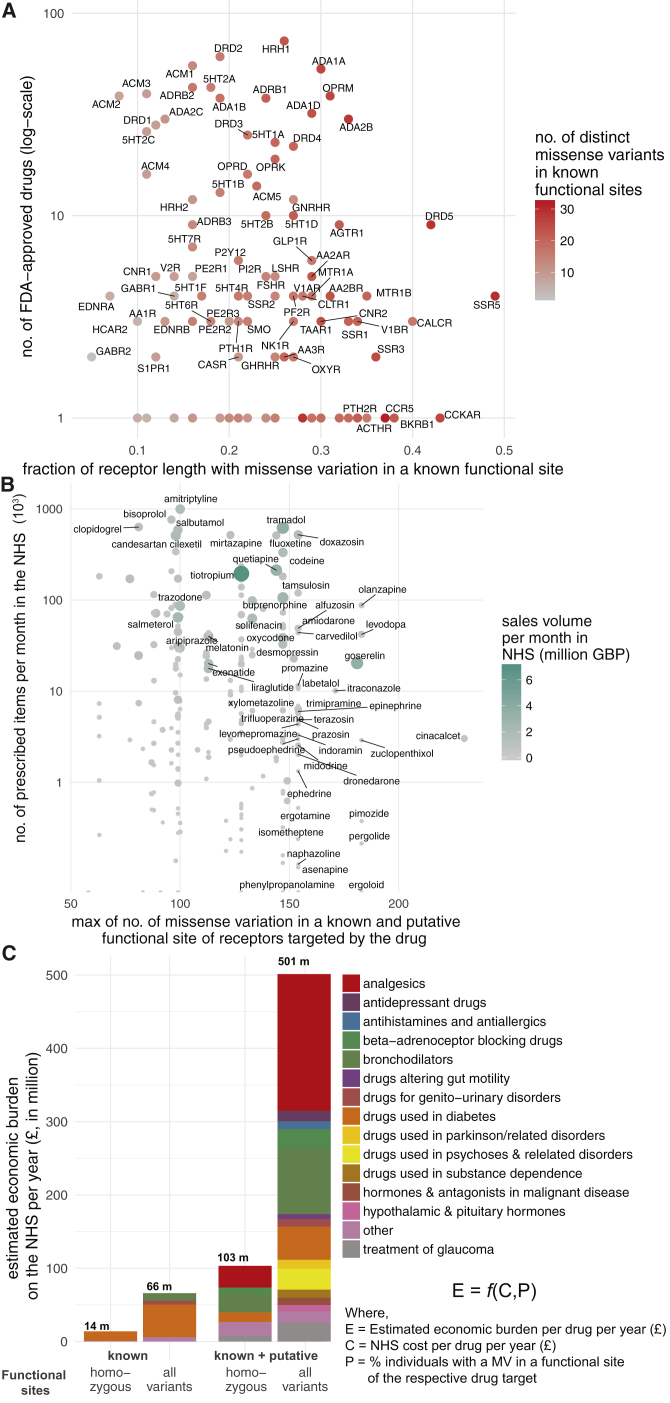
Drugs, GPCR Functional Site Variability, and Associated Economic Impact(A) Number of FDA-approved drugs (y axis, log-scale) against their missense mutation density within known functional sites (x axis) for GPCR drug targets. Color represents the total number of missense variants for each receptor within known functional sites as seen in the ExAC dataset.(B) Number of prescribed items by the National Health Service each month (y axis, log-scale) against the maximum number of missense variations in known and putative functional sites of its therapeutic GPCR target for each FDA-approved drug. UK sales volume is shown in million GBP per month.(C) Estimated economic burden on the National Health Service per year due to ineffective drug prescription (STAR Methods).Please see Table S7 for each drug. See also Figures S6 and S7.